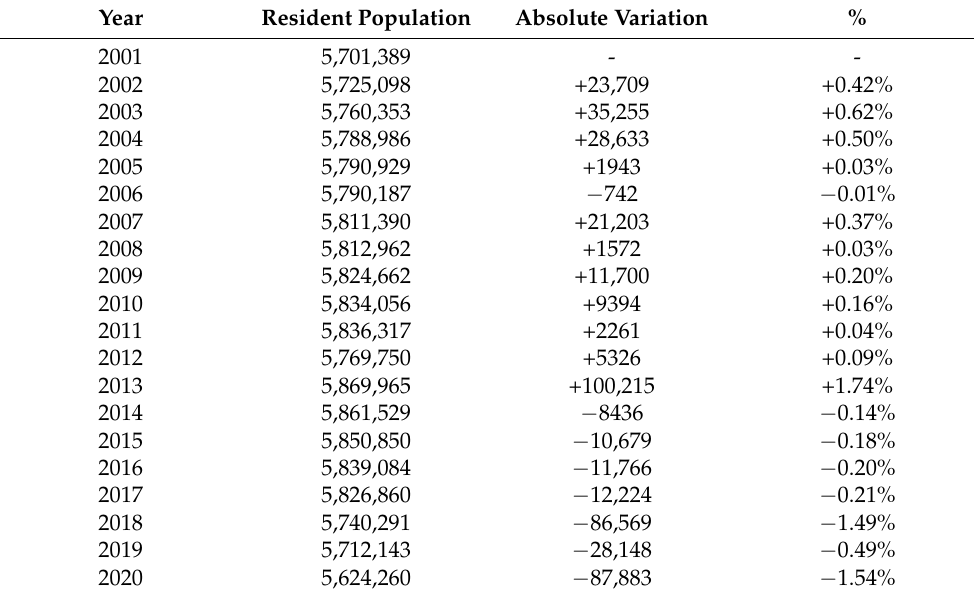
Table 1. Population and absolute and percentage changes in the Campania Region